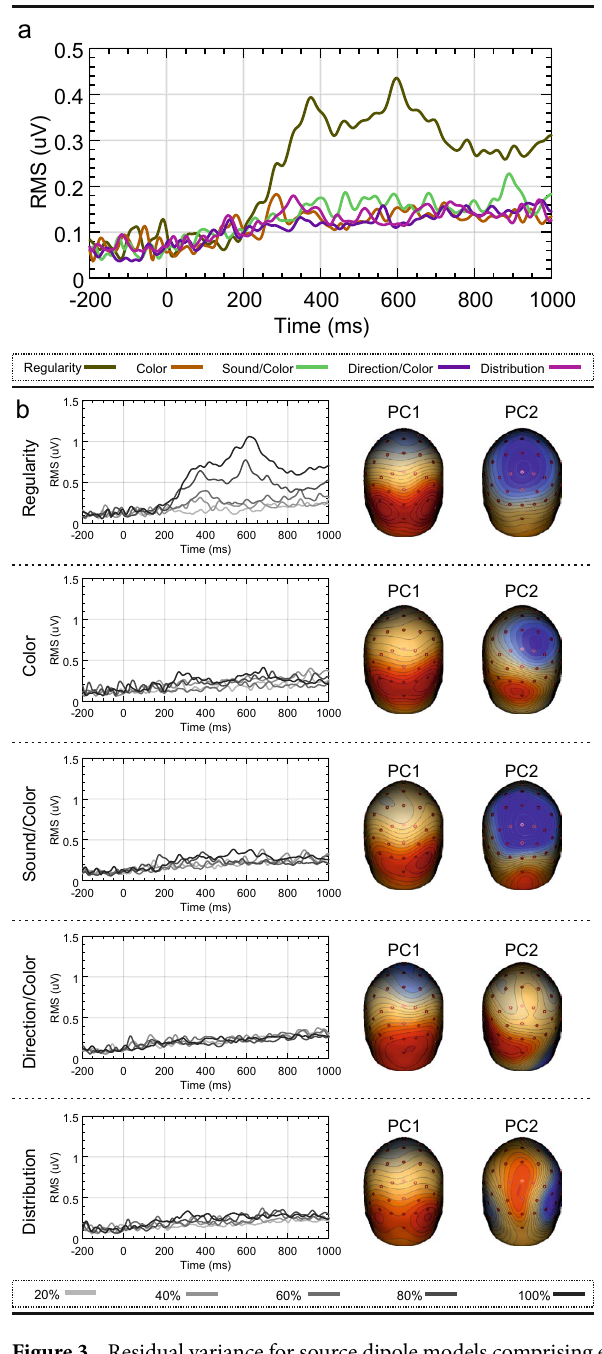
Figure 3. Residual variance for source dipole models comprising extrastriate sources only. ( a ) Residual variance GFP for the source dipole model for each task. ( b ) Residual variance GFP for each source dipole model and condition. Two principle components explaining the greatest amount of variance are also shown. Scalp maps were created using BESA 7.0 (https